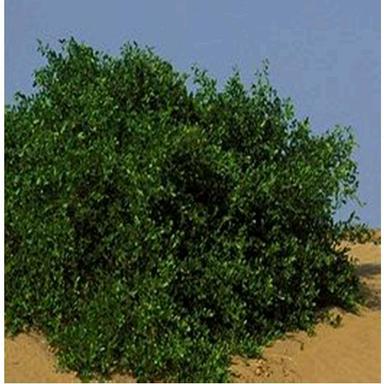
Peelu Crop Field Photograph (Salvadora persica Linn).